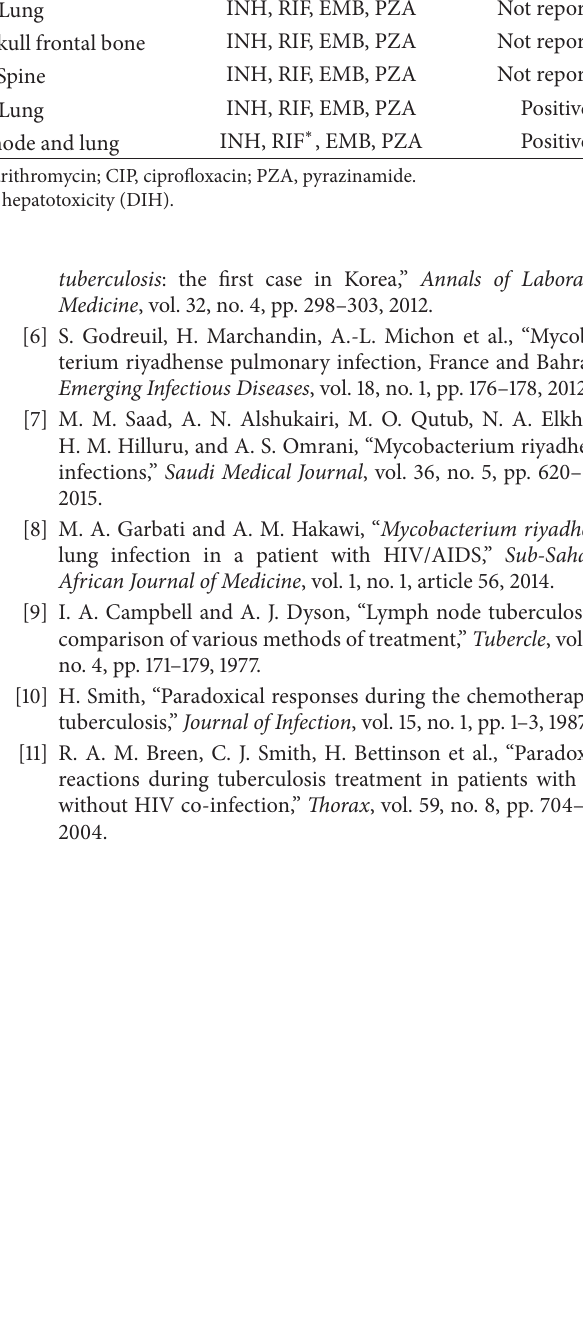
Table 1: The different clinical characteristics in the previous reported cases in comparison to the reported patient. Age (years), Case Country Sites of involvement gender 19,